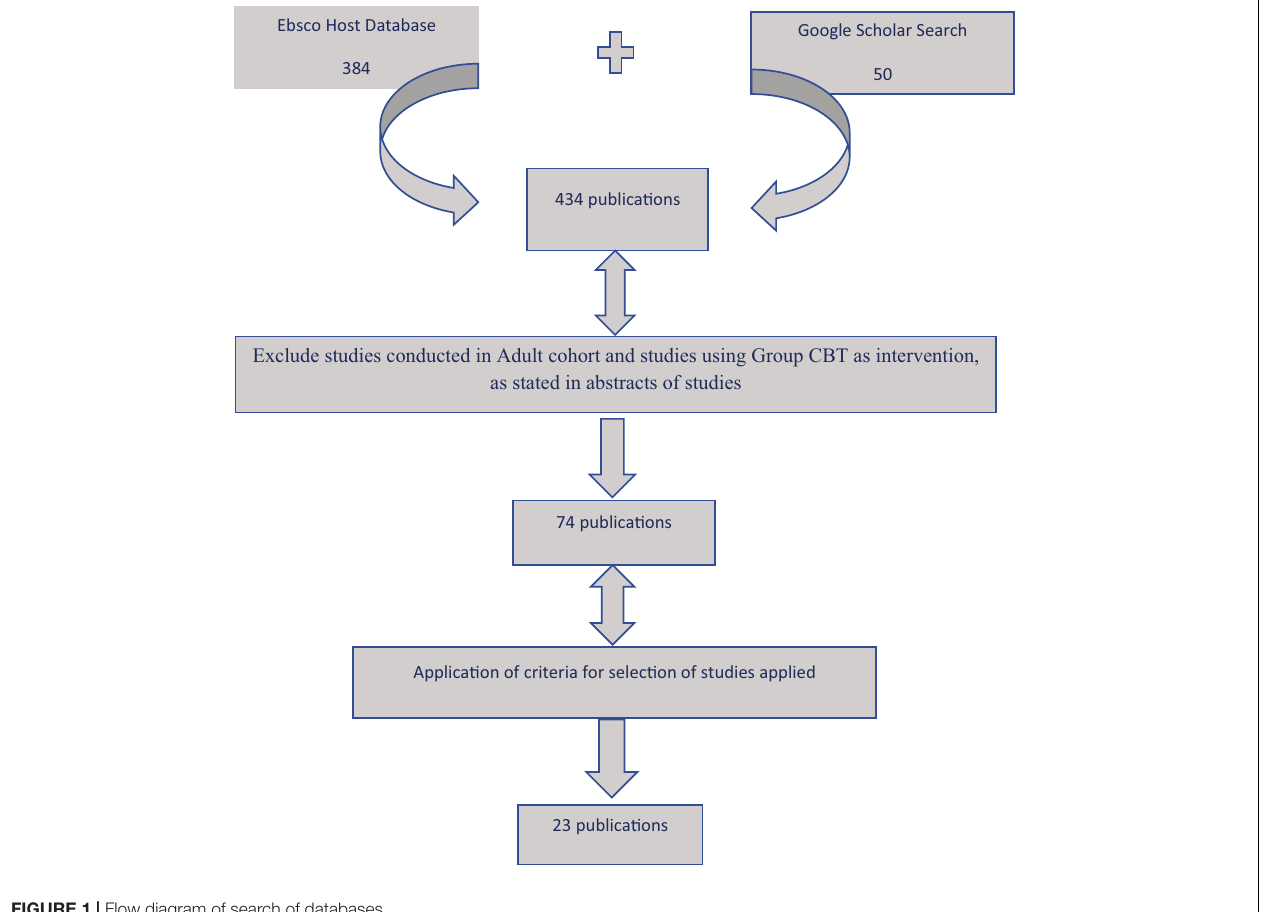
FIGURE 1 | Flow diagram of search of